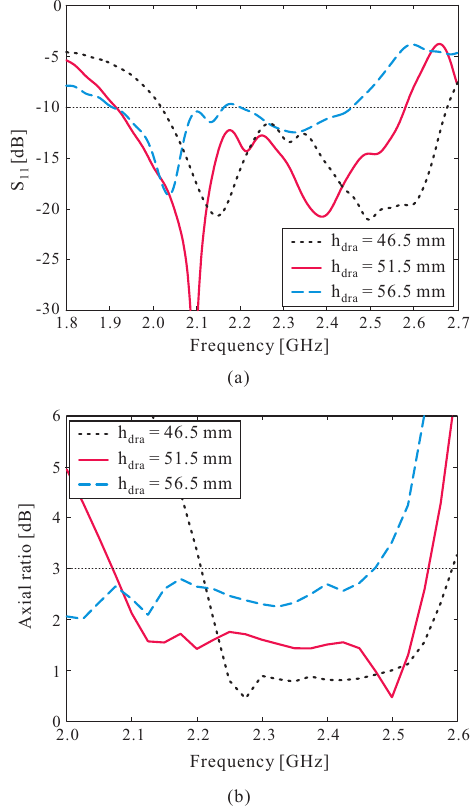
Figure 5. Effect of the DR height h dra on: ( a ) Reflection coefficient; ( b ) Axial ratio.